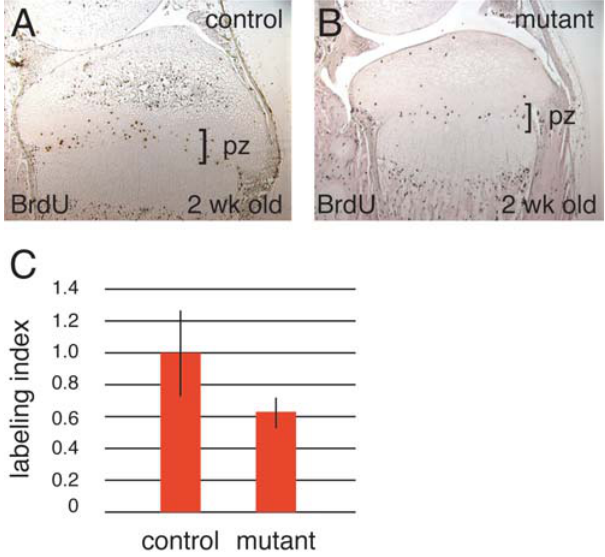
Figure 7. Cell proliferation in the epiphyseal growth plate of the proximal tibia. A, B, BrdU-labeled cells in 2-week-old control and R26 floxneoWnt4 ; Col2a1-Cre mutant mice. C, The fraction of chondrocytes in the proliferation zone (pz) that incorporated BrdU was 0.189 6 0.051 in control mice compared to 0.122 6 0.020 in mutants (P , 0.001). The labeling percentage of the control was designated as 1.0, and the relative percentage of the mutant was calculated as 0.64.